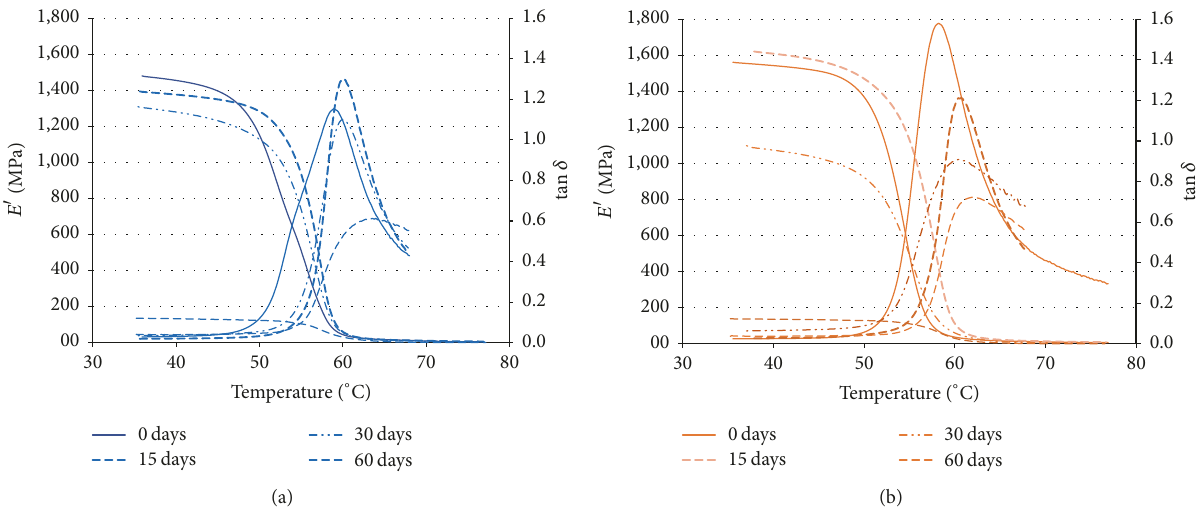
PLGA high T , (i.e., 0, 15, 30, 60, and 120 days) and for PLGA pellet as a